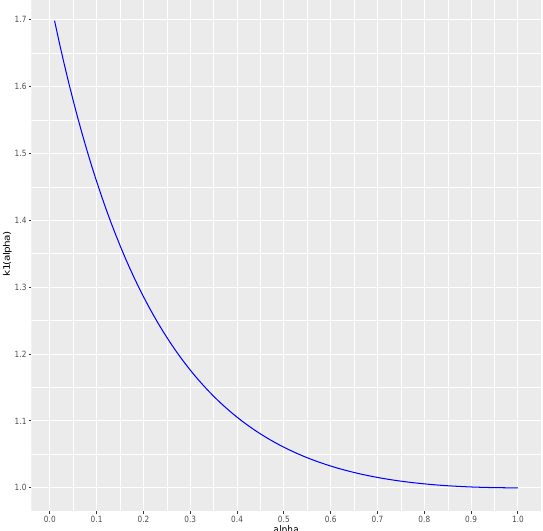
Figure 3.1: k 1 ( α ) = ϕ 1 (cid:0) ψ 1 ( α )/ n (cid:1) )/ ϕ 2 (cid:0) ψ 2 ( α )/ n (cid:1) ) for α ∈ [0, 1]